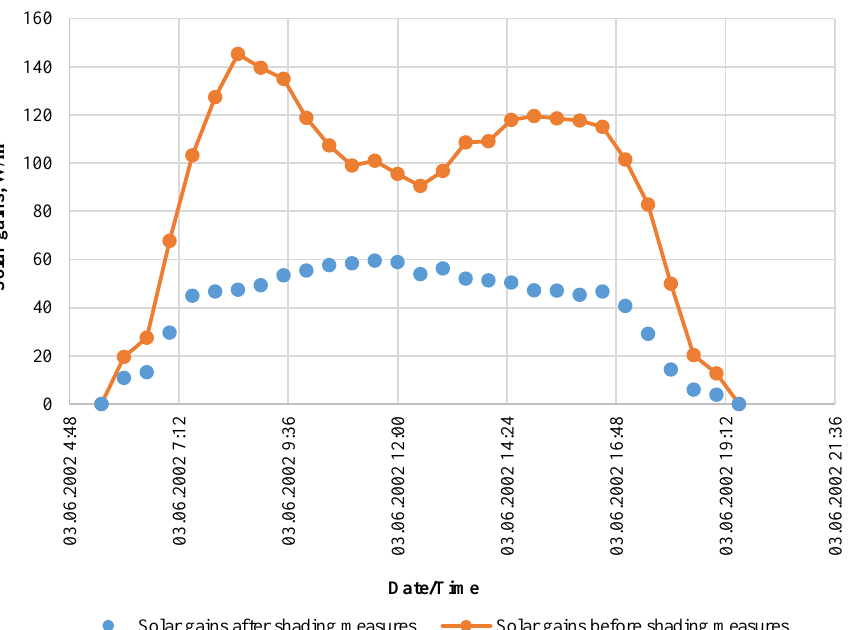
Fig. 13. Comparison of solar gains on Monday, June 3, before and after the passive